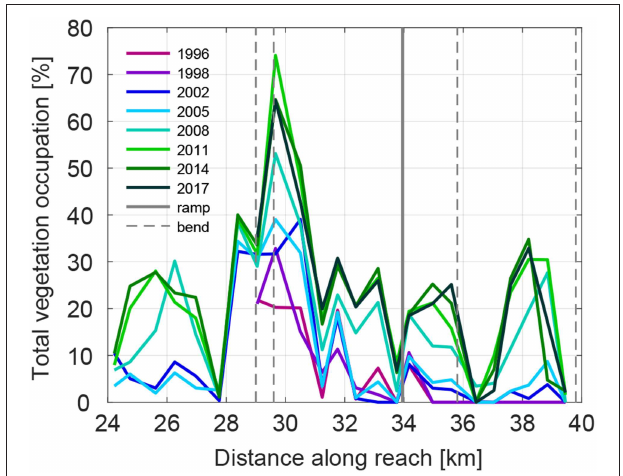
FIGURE 7 | Longitudinal distribution of the total vegetation occupation as proportion of the total exposed area, for reach A. Distances along the reach represent the official Alpine Rhine mileage (see Figure 1 ). The presence of ramps and channel bends are reported with solid and dashed gray lines,